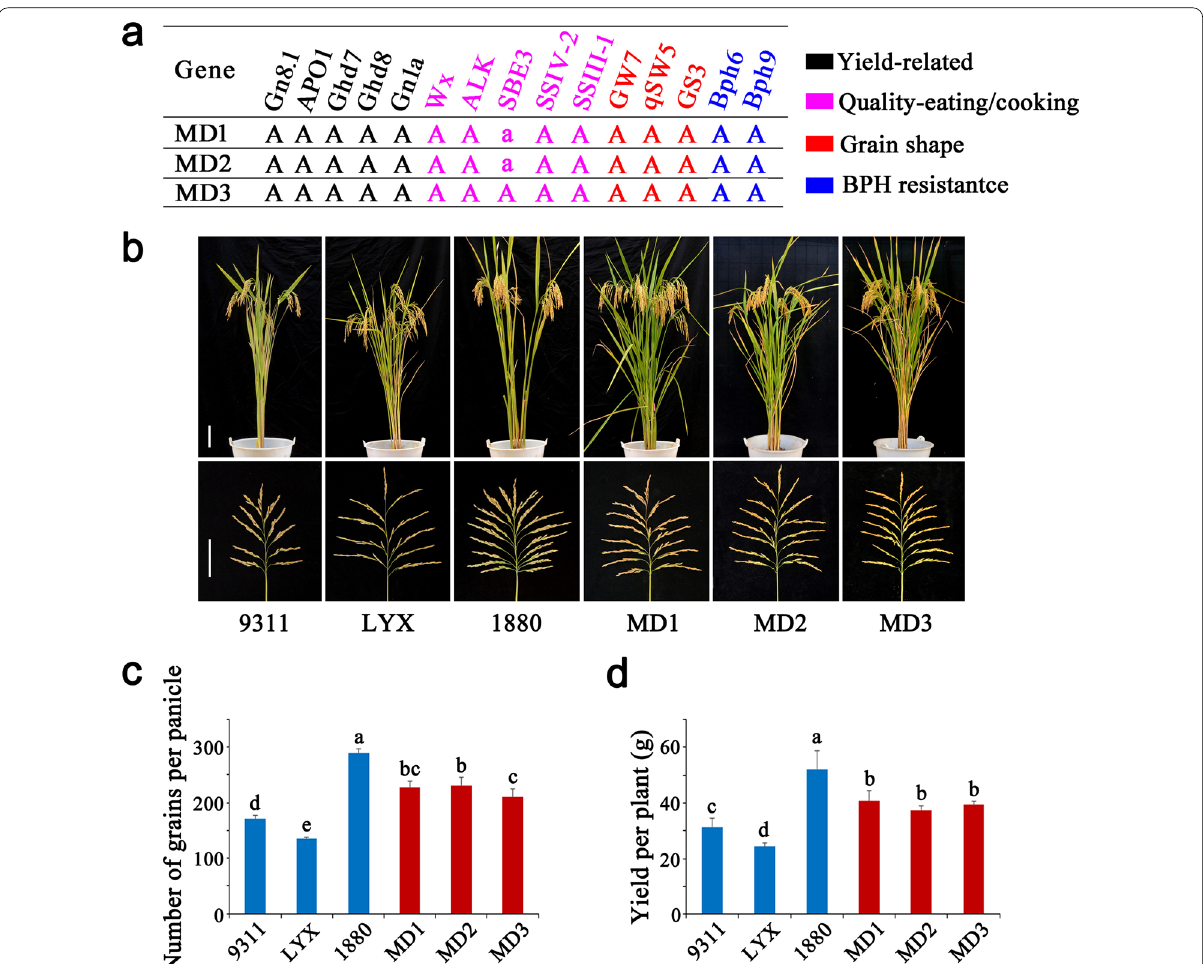
Fig. 4 Gene distribution and yield performance of molecular design breeding lines. a : Genotype of the target genes in MD1, MD2 and MD3. Black represents yield-related genes, pink represents eating and cooking quality related genes, red represents appearance quality related genes, bule represents rice BPH resistance related genes. Uppercase letters represent functional alleles and lowercase letters represent nonfunctional alleles. b : Gross plant and panicle morphologies. Scale bars, 10 cm. c : Number of grains per panicle. d : Yield per plant. Values are the means Letters indicate a significant difference at the 5% significance level by the least significant difference